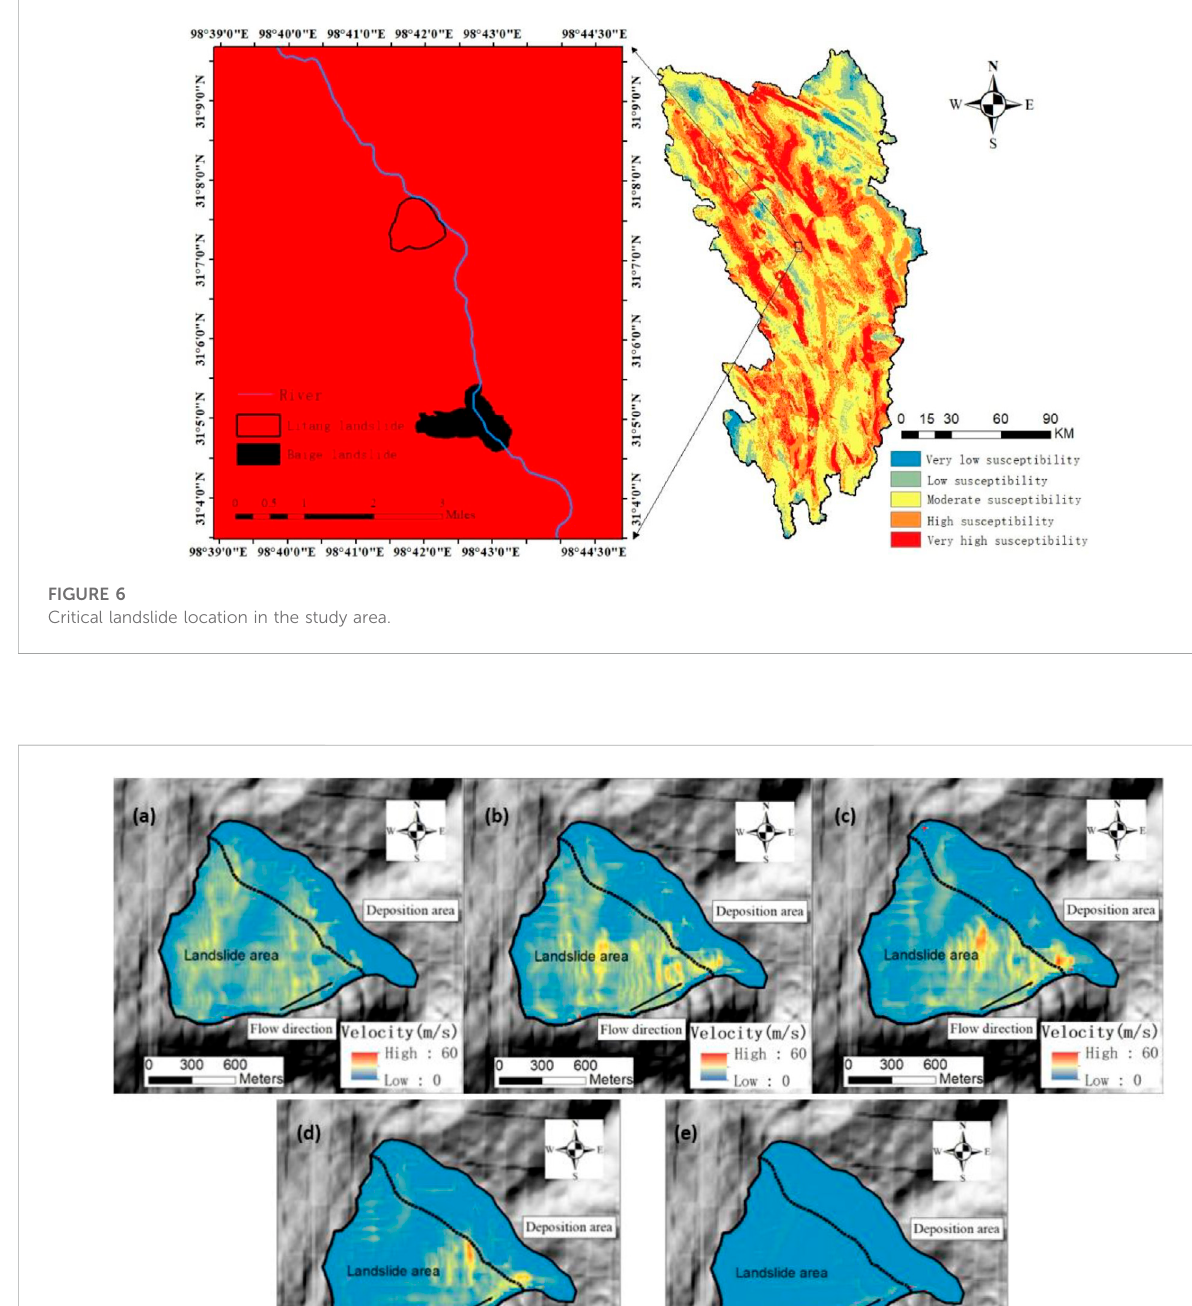
two parts,i.e., upstream and downstream, due to the in fl uence of the watershed in the central section of the landslide. The deceleration stage refers to the period between t = 80 – 100 s Figure 7D). During this stage, the average velocity of the rock mass near the upstream part approaches zero, while the average velocity of the rock mass near the downstream part is < 10 m/s.